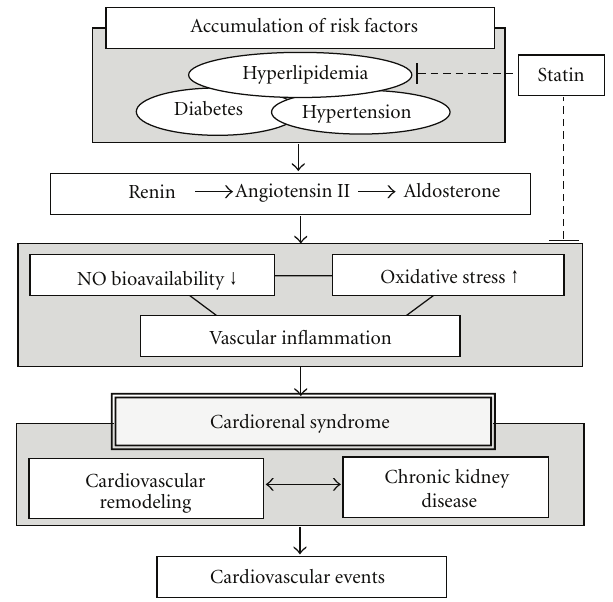
Figure 1: Activation of the renin-angiotensin-aldosterone system due to accumulation of cardiovascular risk factors causes imbalance between nitric oxide (NO) bioavailability and oxidative stress, lead- ing to vascular inflammation. This upstream signaling exacerbates cardiorenal syndrome and evokes cardiovascular events. Statins ameliorate not only the serum lipid profile but also oxidative stress, NO bioavailability, and vascular inflammation by their pleiotropic e ff